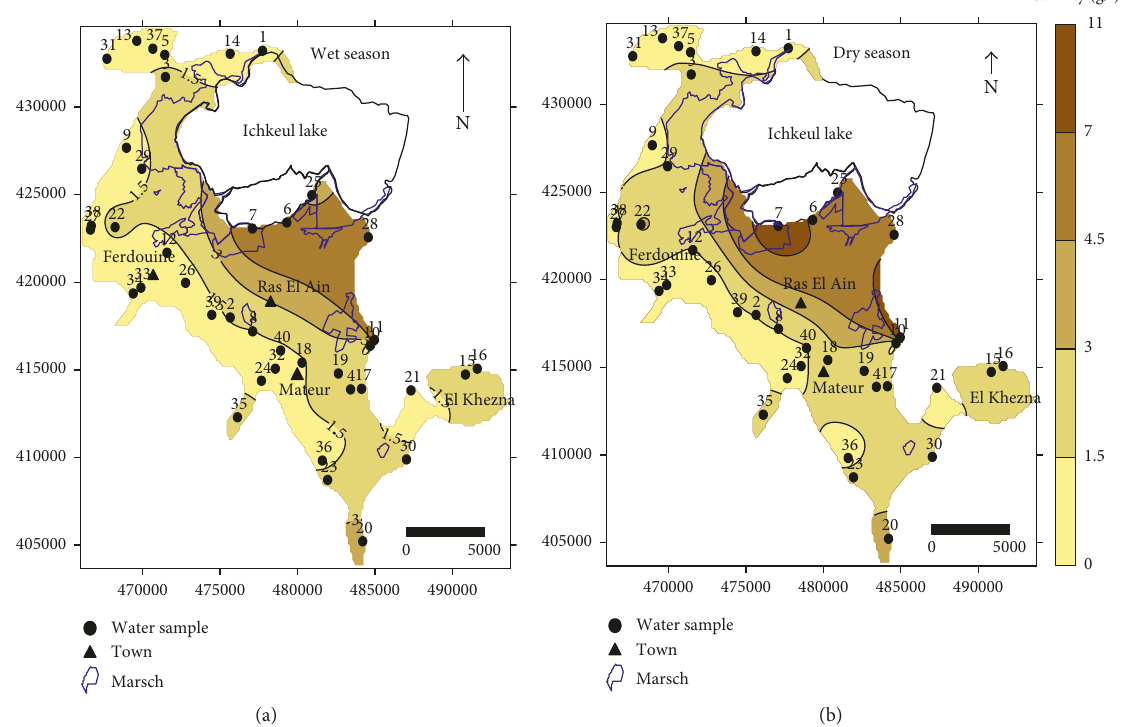
Figure 5: Spatial distribution maps of salinity: (a) wet season and (b) dry